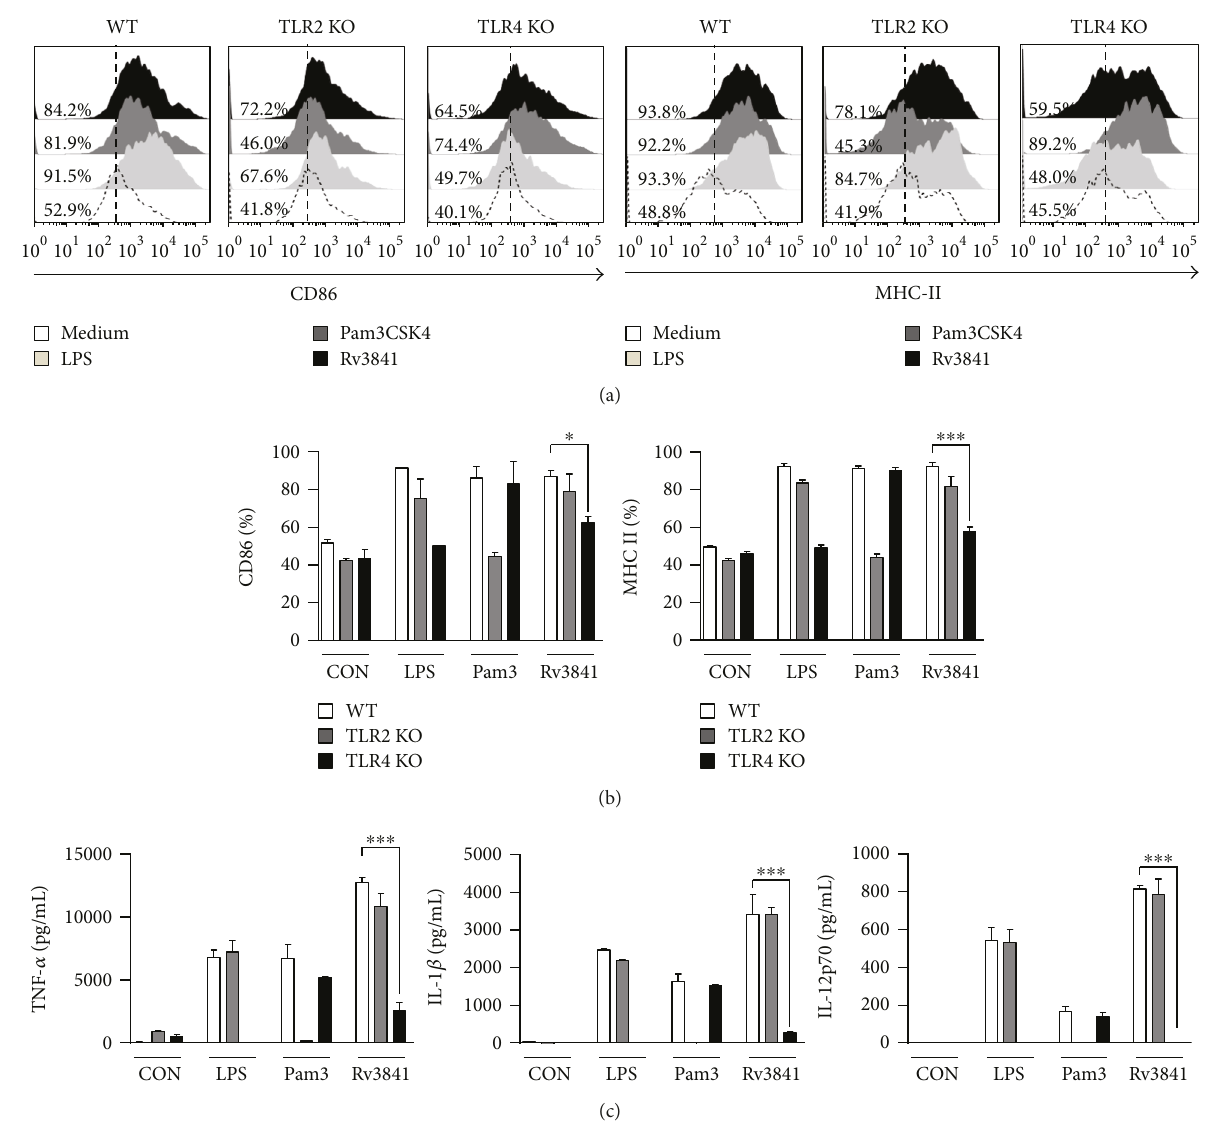
Figure 3: Rv3841 induces DC activation via TLR4. (a, b) Bar graphs showing the level of CD86 or MHC class II expression on Rv3841-treated CD11c + -gated DCs derived from WT, TLR2 − / − , or TLR4 − / − mice. DCs derived from WT, TLR2 − / − , or TLR4 − / − mice were treated with Rv3841 (10 μ g/mL) for 24 h. The percentage of positive cells is shown in each panel. The bar graphs present the mean percentage ± SEM for each surface molecule on CD11c + cells across three independent experiments. ∗∗∗ p < 0 001 , as determined by one-way ANOVA. (c) DCs derived from WT, TLR2 − / − , or TLR4 − / − mice were treated with Rv3841 (10 μ g/mL) or LPS (100ng/mL) for 24h. The TNF- α , IL-1 β , or IL- 12p70 production of Rv3841- or LPS-treated DCs derived from WT, TLR2 − / − , or TLR4 − / − mice was quanti fi ed by ELISAs. All the data were expressed as mean ± SD ( n = 3 ); ∗ p < 0 05 or ∗∗∗ p < 0 001 : a signi fi cant di ff erence of Rv3841-treated TLR4 − / − DC groups from Rv3841-treated WT DC control groups and other controls, as determined by one-way